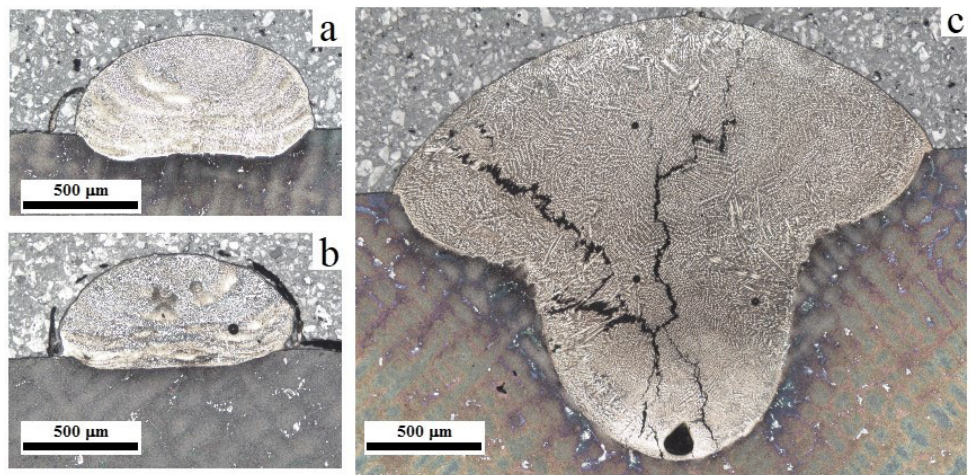
Figure 7. Macrostructure of cladding beads: ( a , b ) samples without macrodefects (process parameter 200 W 3 mm/s and 200 W 9 mm/s, respectively); ( c ) sample with cracks (process parameter 600 W 9 mm/s).